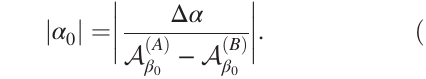
≡ log 1 þ ρ − ρ = ð 1 − ρ log 10 2 is a function defined in Ref. [13] 10 ½ð cor Þ cor Þ cor Þ(cid:3) cor